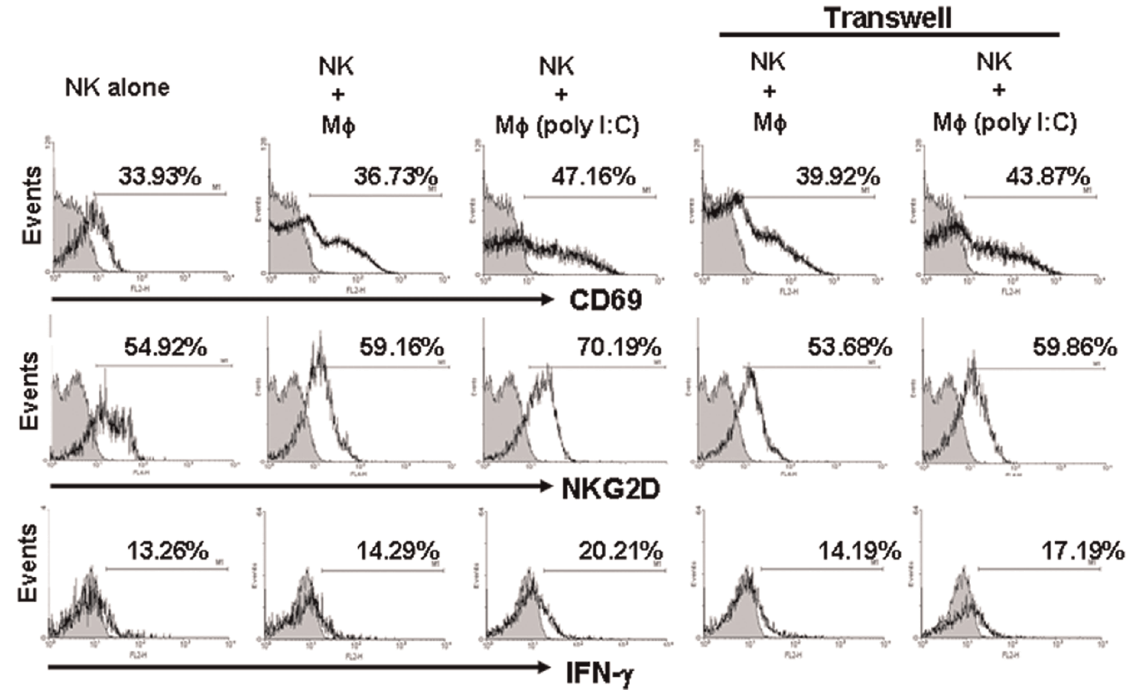
Figure 7. Both cell-to-cell contact and cytokines were involved in the crosstalk between NK cells and macrophages. Freshly isolated murine NK cells were co-cultured with poly I:C-stimulated primary macrophages separated by a transwell for 24 h. Then NK cells were stained with antibodies for cell-surface CD69 and NKG2D, and for intracellular IFN- c . The numbers of CD69- or NKG2D-positive as well as IFN- c -secreting NK cells were determined by flow cytometry. Data are expressed as the percentage of positively-stained cells. The data are representatives from at least three separate experiments.